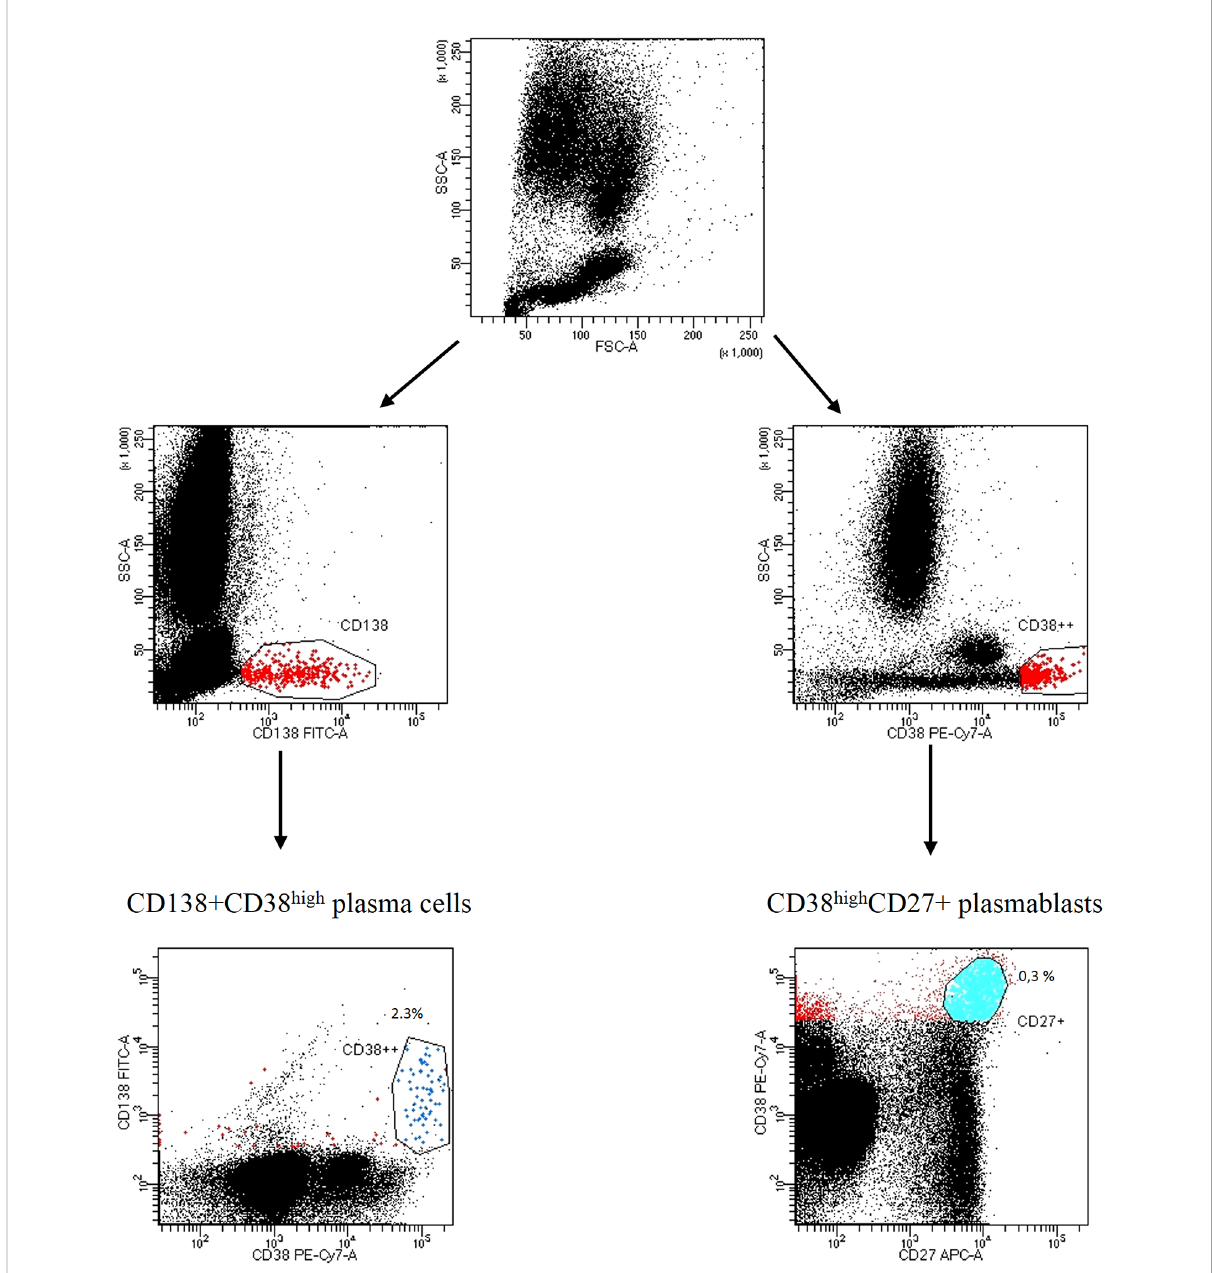
FIGURE 1 Gating strategy of CD138CD38 high plasma cells and CD27+CD38 high plasmablasts Representative dot plots from a SSc patient. Lymphocytes were identi fi ed and gated according to SSC-A (granularity) vs FSC-A (size). Plasma cells were distinguished by CD138+CD38 high expression; plasmablasts were identi fi ed by CD27+CD38 high